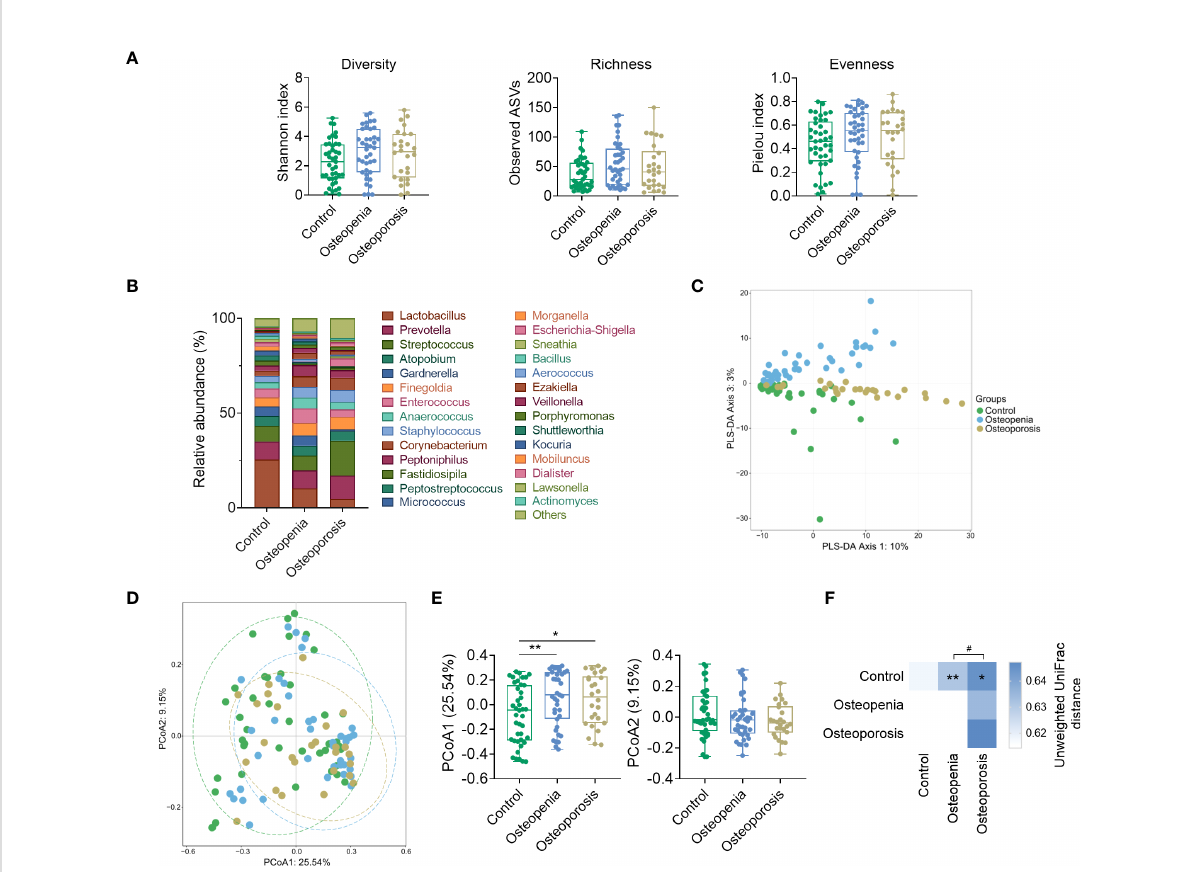
FIGURE 3 Structure and composition of VM among the control, osteopenia, and osteoporosis groups. (A) Diversity, richness, and evenness of VM in the groups. (B) Bar plot showing the relative abundance of each genus in the VM. Only genera whose average relative abundances are greater than 1% among the samples are shown. (C) PLS-DA plot. (D) Principal component analysis plot based on unweighted UniFrac distance. (E) Comparisons of sites in principal components 1 and 2. (F) PERMANOVA test result based on unweighted UniFrac distance of VM and the comparison of unweighted UniFrac distances between the microbiota of women in the osteopenia, osteoporosis, and control groups. * and ** represent PERMANOVA p -values < 0.05 and < 0.01, respectively. # represents p < 0.05 from the Wilcoxon rank-sum test of the